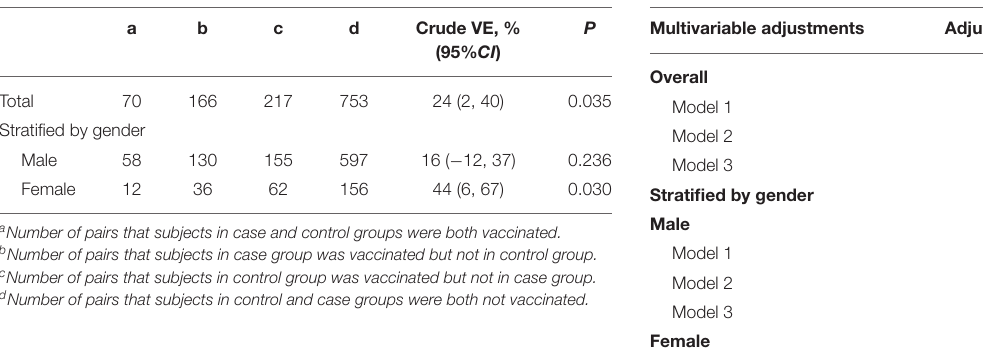
TABLE 3 | Adjusted VE of PPV23 vaccination against pneumococcal diseases among people aged 60 years or older. Multivariable adjustments